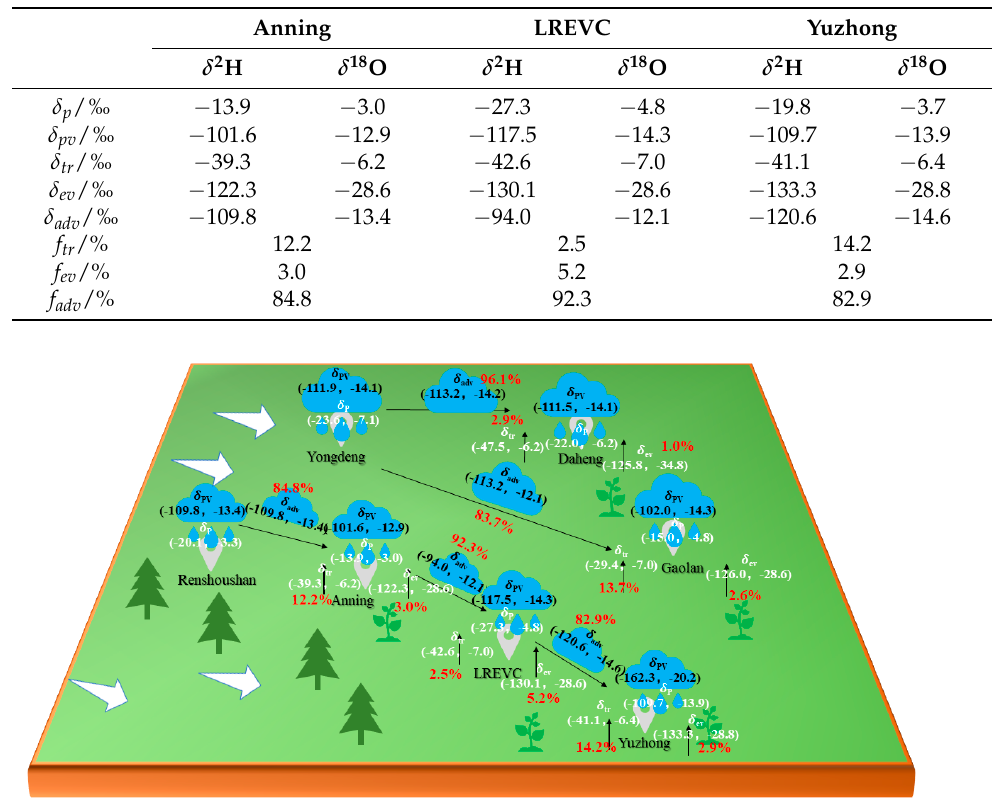
Figure 2. Moisture recycling pattern along the trajectories of Renshoushan–Anning–LREVC–Yuzhong and Yongdeng–Daheng/Gaolan based on a three-component mixing model.